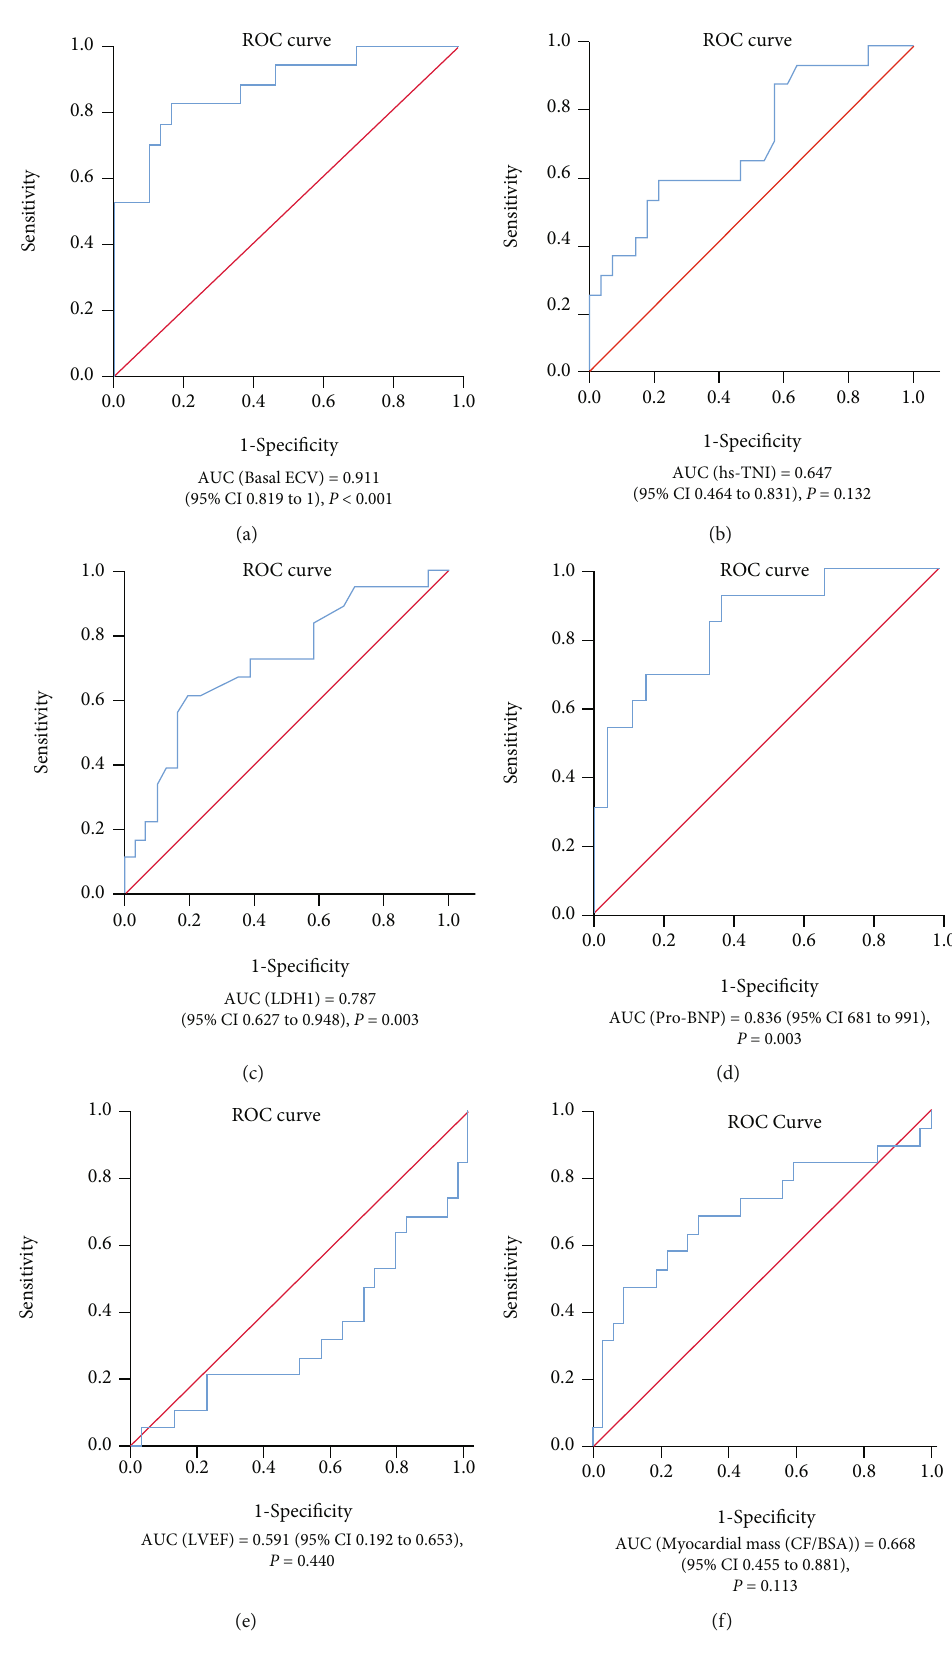
Figure 5: ROC curve for predicting CA by (a) basal ECV, (b) hs-TNI, (c) LDH1, (d) pro-BNP, (e) LVEF, and (f) myocardial mass